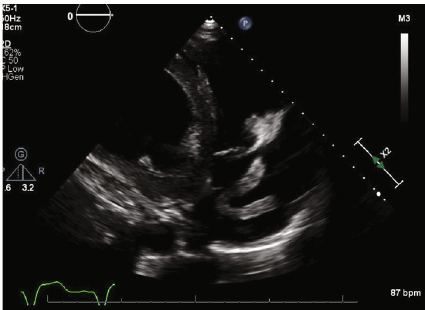
Figure 2: Aspiration catheter engaging the thrombus.